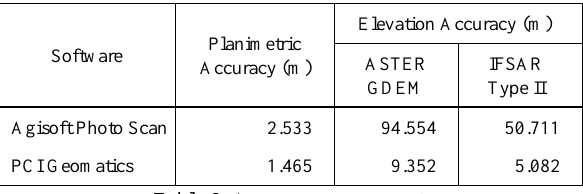
Figure 4. Discrepancies between UAV and IFSAR DEM